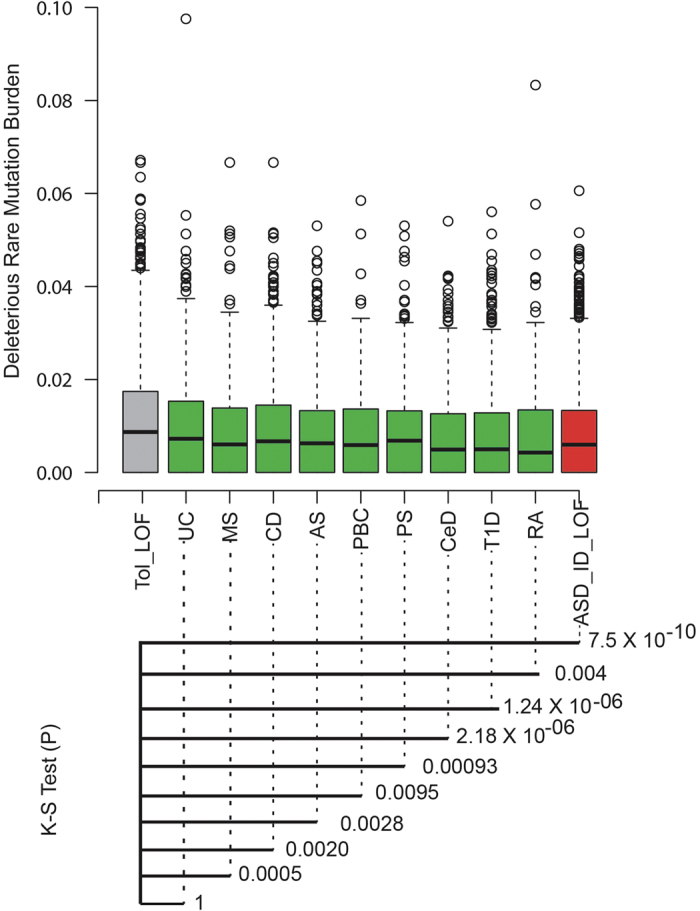
The burden of recent deleterious mutation accumulation.The deleterious mutation burden (rare missense and LOF) for each exon (normalized by exon length) was computed for phenotype (red and green) and non-phenotype tolerated gene sets (grey). The whisker plot shows each bar with minimum and maximum quartiles. The grey bar represents the accumulation of exonic rare deleterious LOF mutations within genes that are tolerated in humans for LOF mutations. The green bar represents the immune mediated disease and the red bar represents genes reported to have deleterious LOF mutations in autism spectrum disorder (ASD). The significance (K-S test p-value) of rare deleterious mutation accumulation for a phenotype was obtained by comparing the burden distribution between tolerated and phenotypic genes.